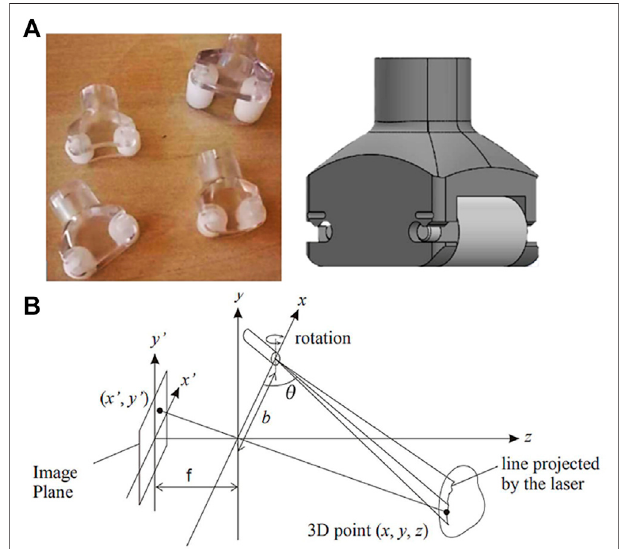
FIGURE 1 | (A) LPG device used at Meyer Children Hospital; (B) geometry of triangulation technique: the lens are located at the origin, with